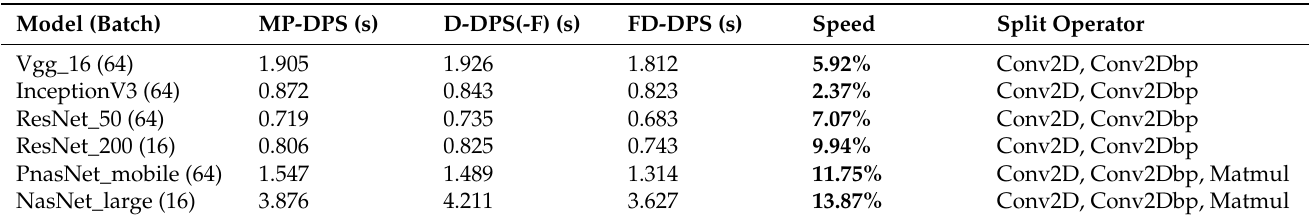
Table 7. Single-round iteration time comparison of intra-operator parallelism FD-DPS and baseline with 4